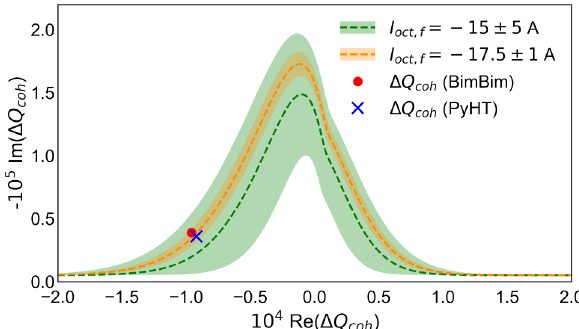
FIG. 10. The dashed lines are stability diagrams obtained with the P y SSD code for two different Landau octupole currents I − 15 (cid:3) 5 A (green) and I − 17 . 5 (cid:3) 1 A (orange). oct ;f ¼ oct ;f ¼ The colored areas are the corresponding uncertainties. The former FIG. 11. P y HEADTAIL results of the bunch centroid motion over corresponds to the values obtained experimentally, while the 3 × 10 5 turns in the LHC for different values of the rf quadrupole latter is determined from the unperturbed complex coherent tune shifts (red circle: B im B im , blue cross: P y HEADTAIL ). strength b ð 2 Þ